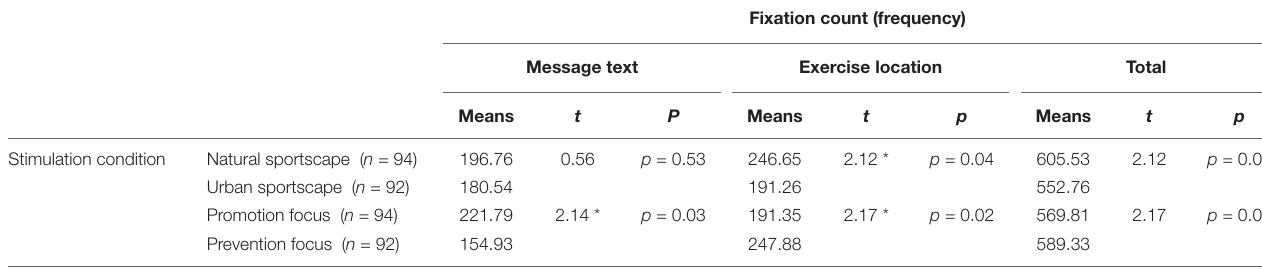
TABLE 3 | The average fixation count (frequency) of eye movement under the stimulation conditions: message text and exercise location.